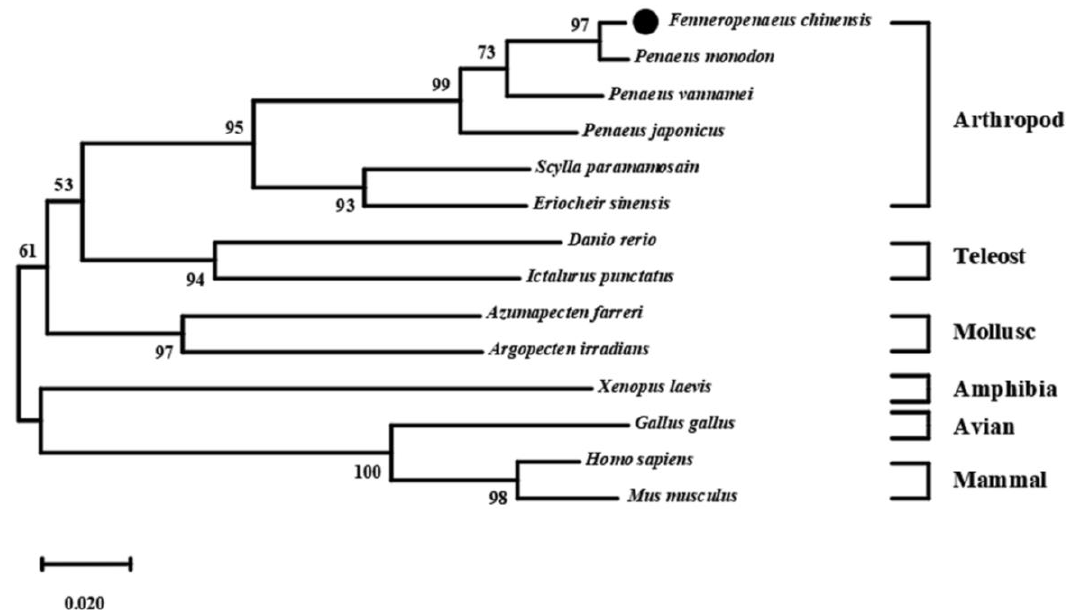
Fig. 3 Neighbor-Joining (NJ) phylogenic tree of Fc CypA constructed based on the protein sequences from different organisms. To derive confidence value for the phylogeny analysis, bootstrap trials were 1000 replicates. The black round indicated the tetraspanin protein of Fc CypA The numbers at the forks indicated the bootstrap